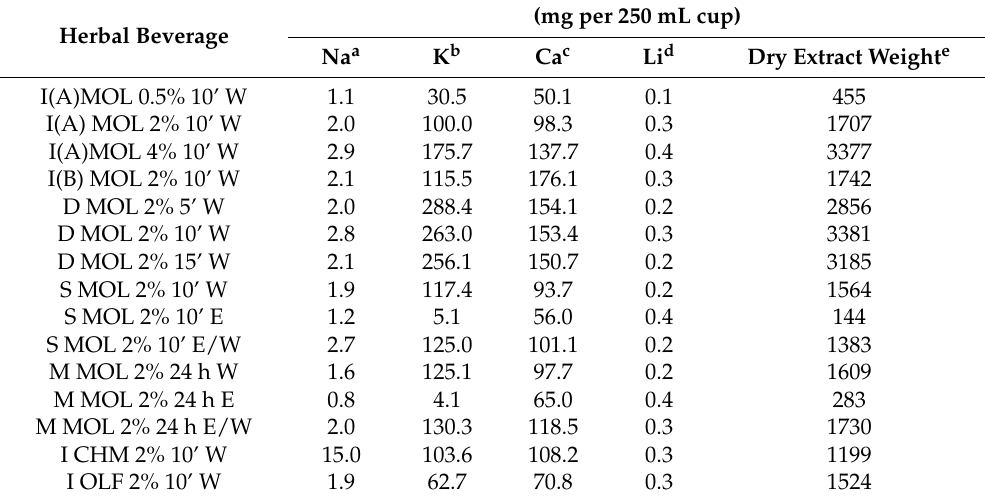
Table 1. Na, K, Ca and Li content of herbal preparations expressed as mg per 250 mL cup and mg dry extract (n = 2) contained in 250mL cup (MOL: Melissa Officinalis L; CHM: Chamomile; OLF: Olive leaf).